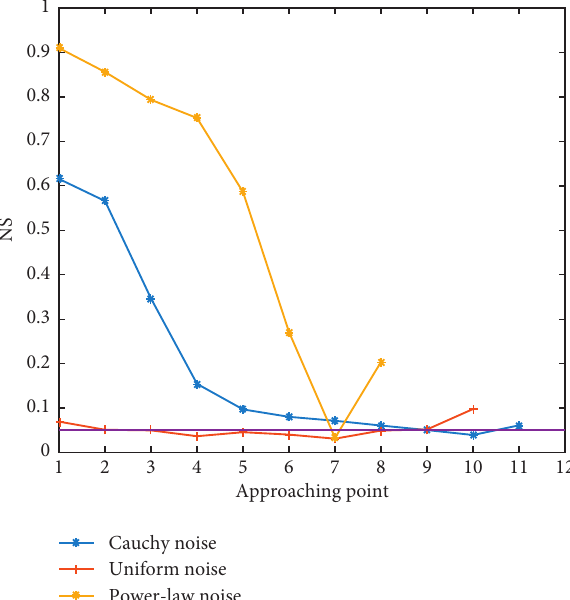
Figure 6: Calibration procedure for different noise types.